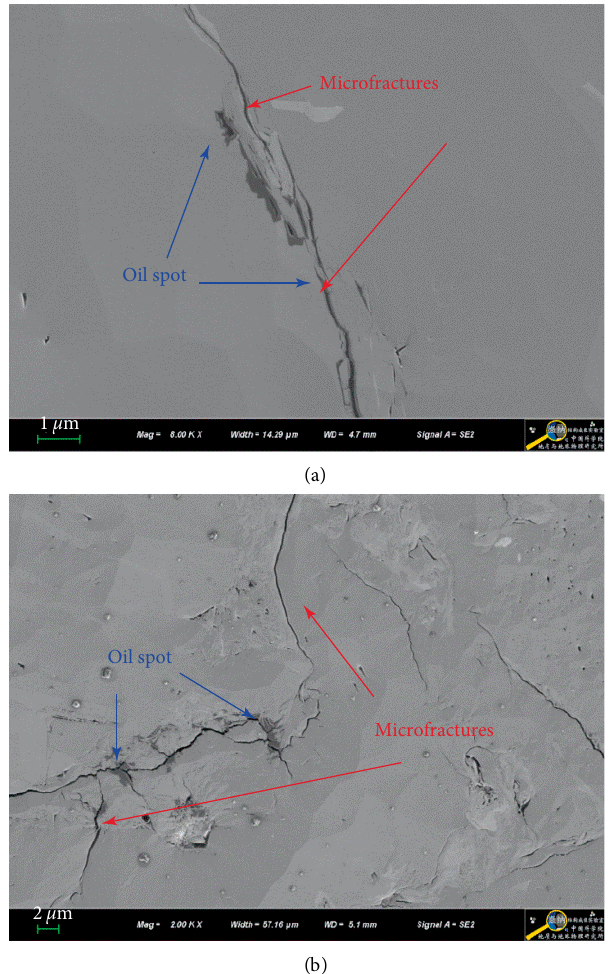
Figure 6: The oil distribution characteristics in